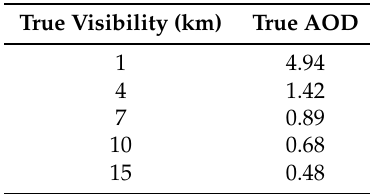
Table 1. Visibility and corresponding AOD values considered as true values for experiments with high scattering conditions with column water vapor equals 2.0 g cm − 2